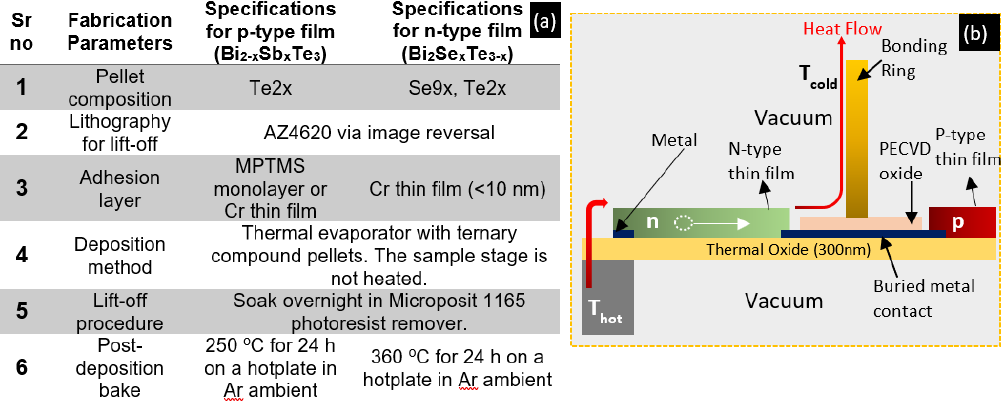
Figure 11. ( a ) Table showing the parameters used for the thermoelectric thin film deposition after optimization. ( b ) Cross-sectional schematic view of a hybrid heat flow planar TEG excluding the top and bottom headers.